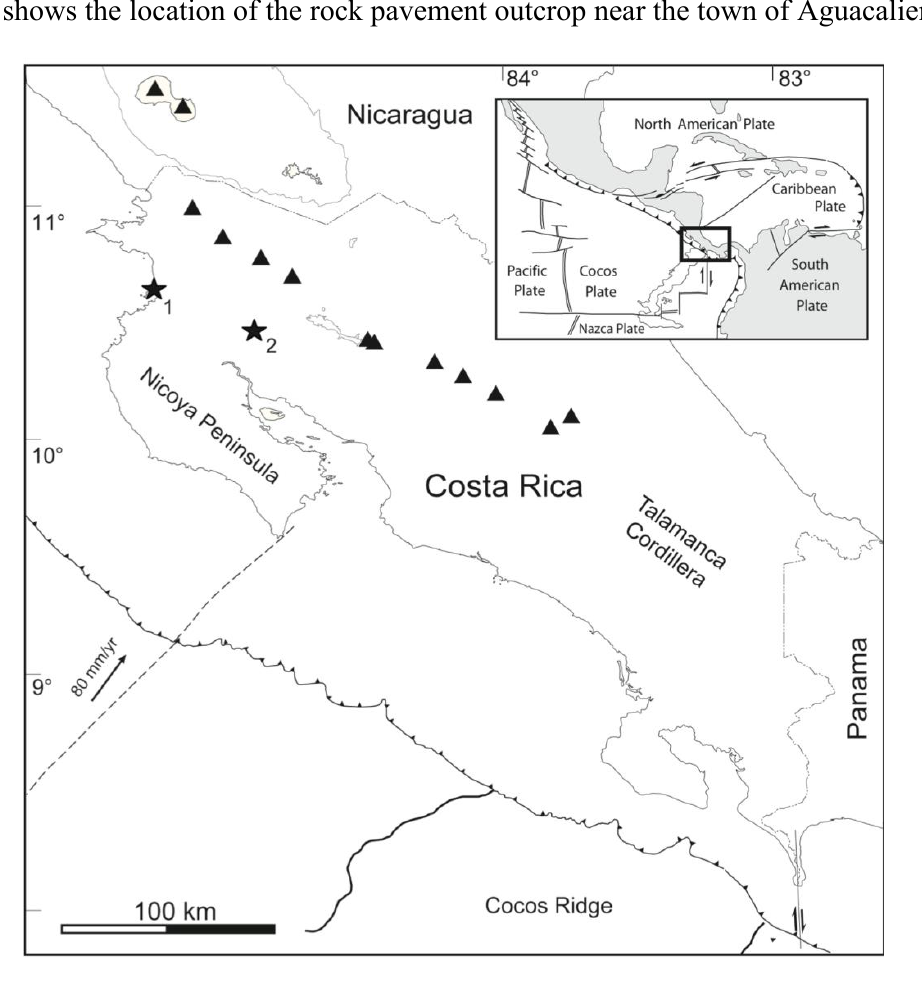
Figure 1. Map after [36] showing the location of the Central American Volcanic Arc in Costa Rica and the location of the outcrops of the Papagayo Tuff. Triangles represent volcanic centers along the volcanic front. The locations of Papagayo Tuff outcrops are indicated by stars. “1” represents the location of the 23-m section exposed at Bahía Culebra and “2” shows the location of the rock pavement outcrop near the town of